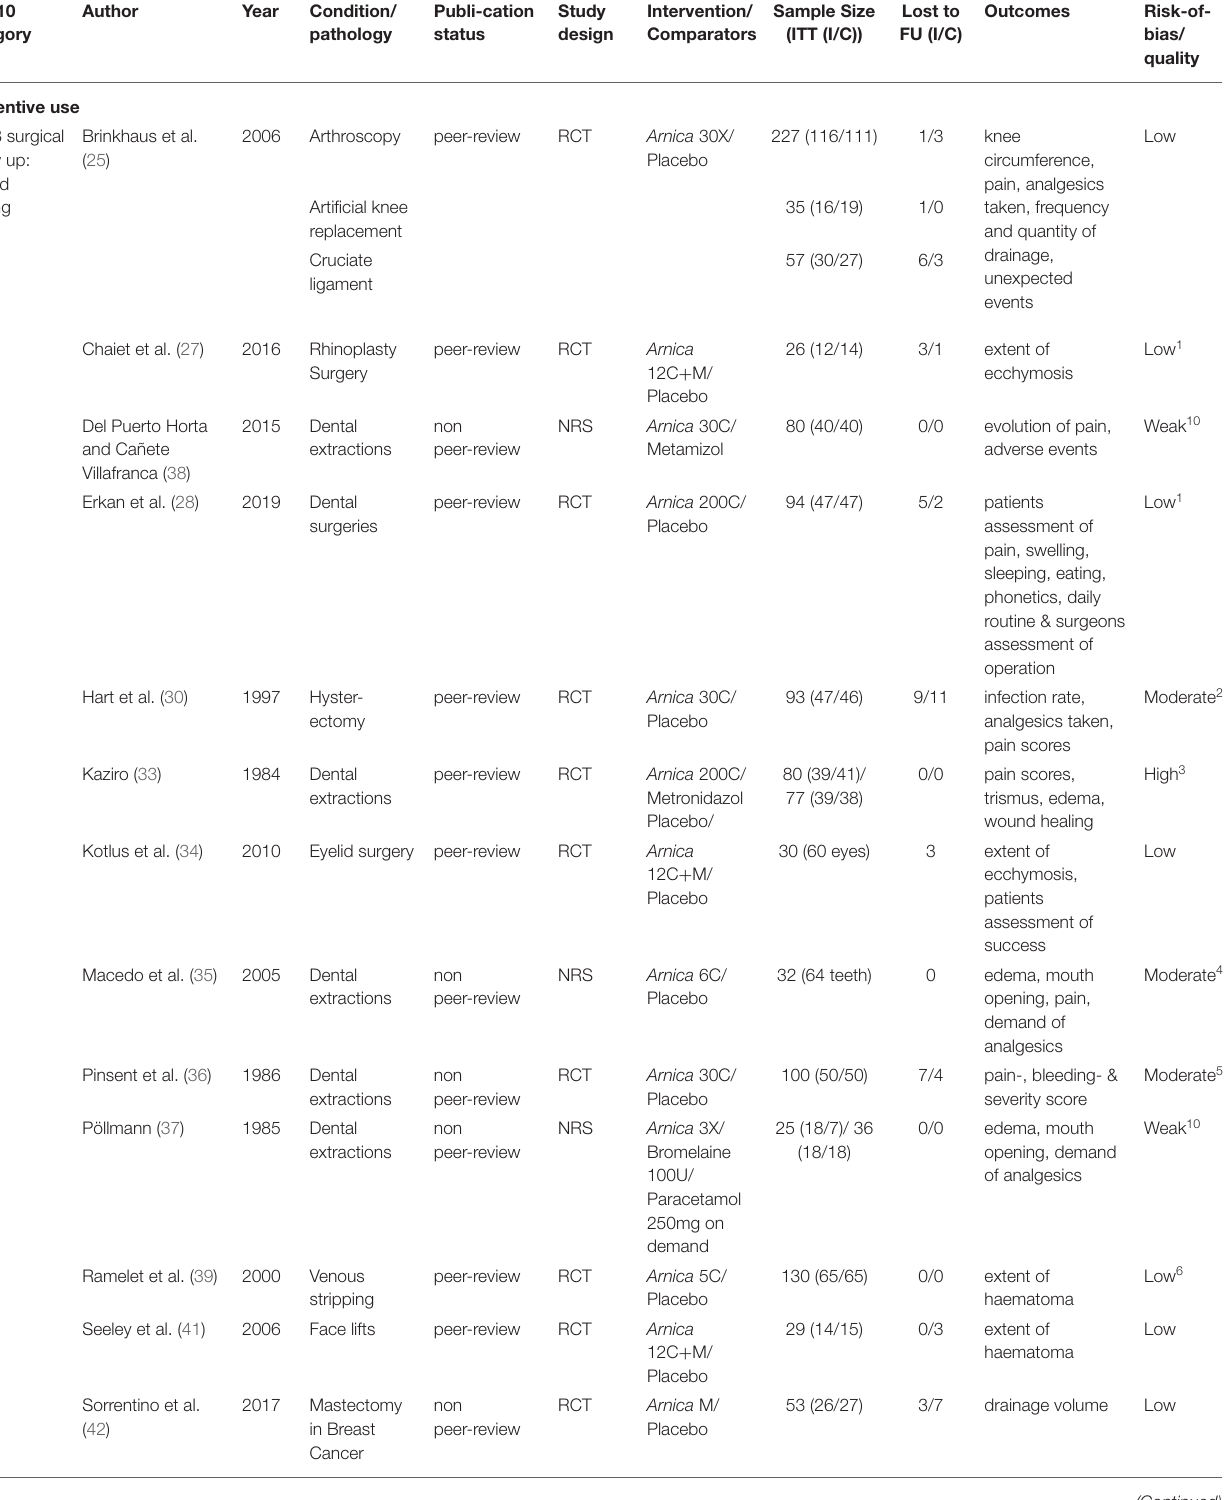
TABLE 1 | Characteristics of included studies. ICD-10